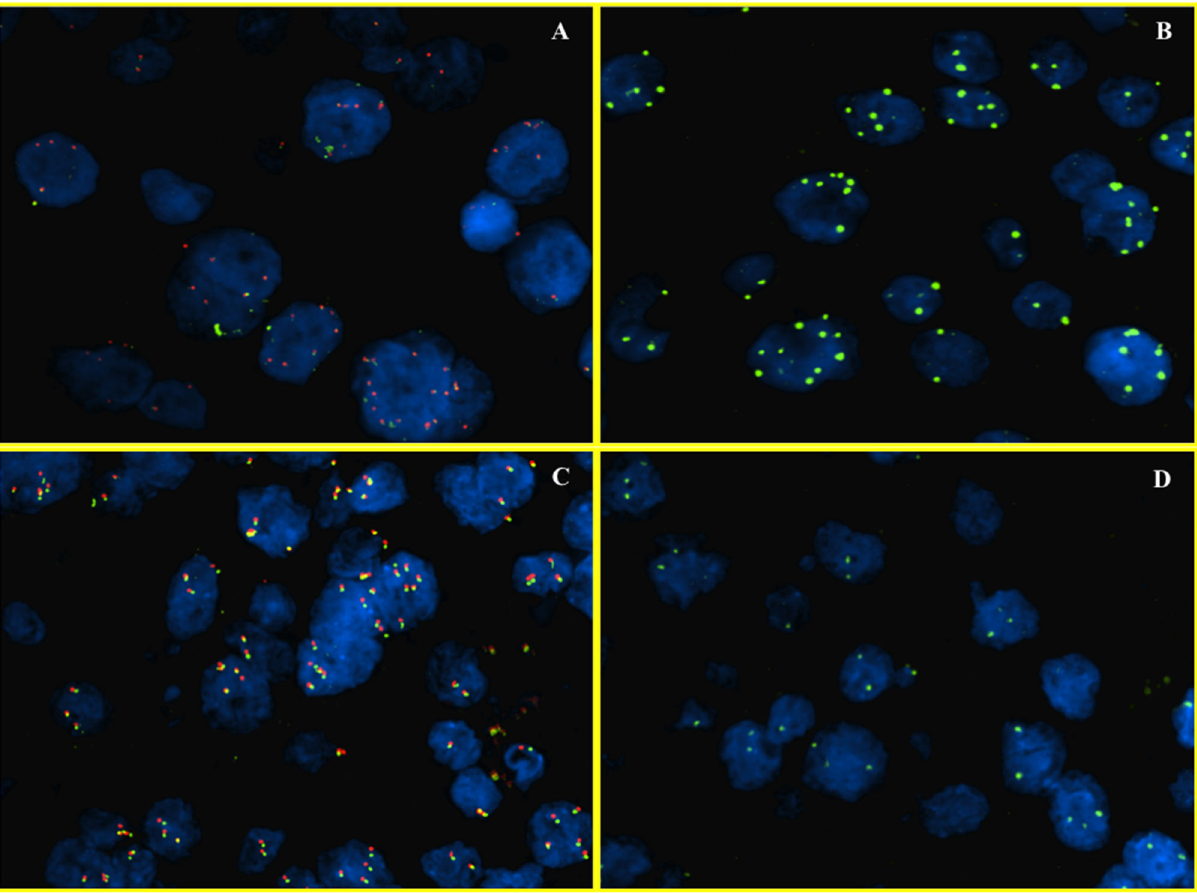
Figure 3. FISH analysis of c-myc (polysomy of 8q and c-myc gene amplification). Dual color fluorescence in situ hybridization with a centromere probe for chromosome 8 (CEP8, Spectrum Green), and region-specific probe for c-myc (Spectrum Orange), in representative hepatocellular carcinoma foci. In the first two images, HCC nuclei have multiple signals both for the c-myc gene (A) and chromosome 8 (B). This case has a polysomic status. In the other two images there are >10% of nuclei with multiple signals for c-myc (C) but two for chromosome 8 (D). This case is representative of amplification for c-myc. doi: